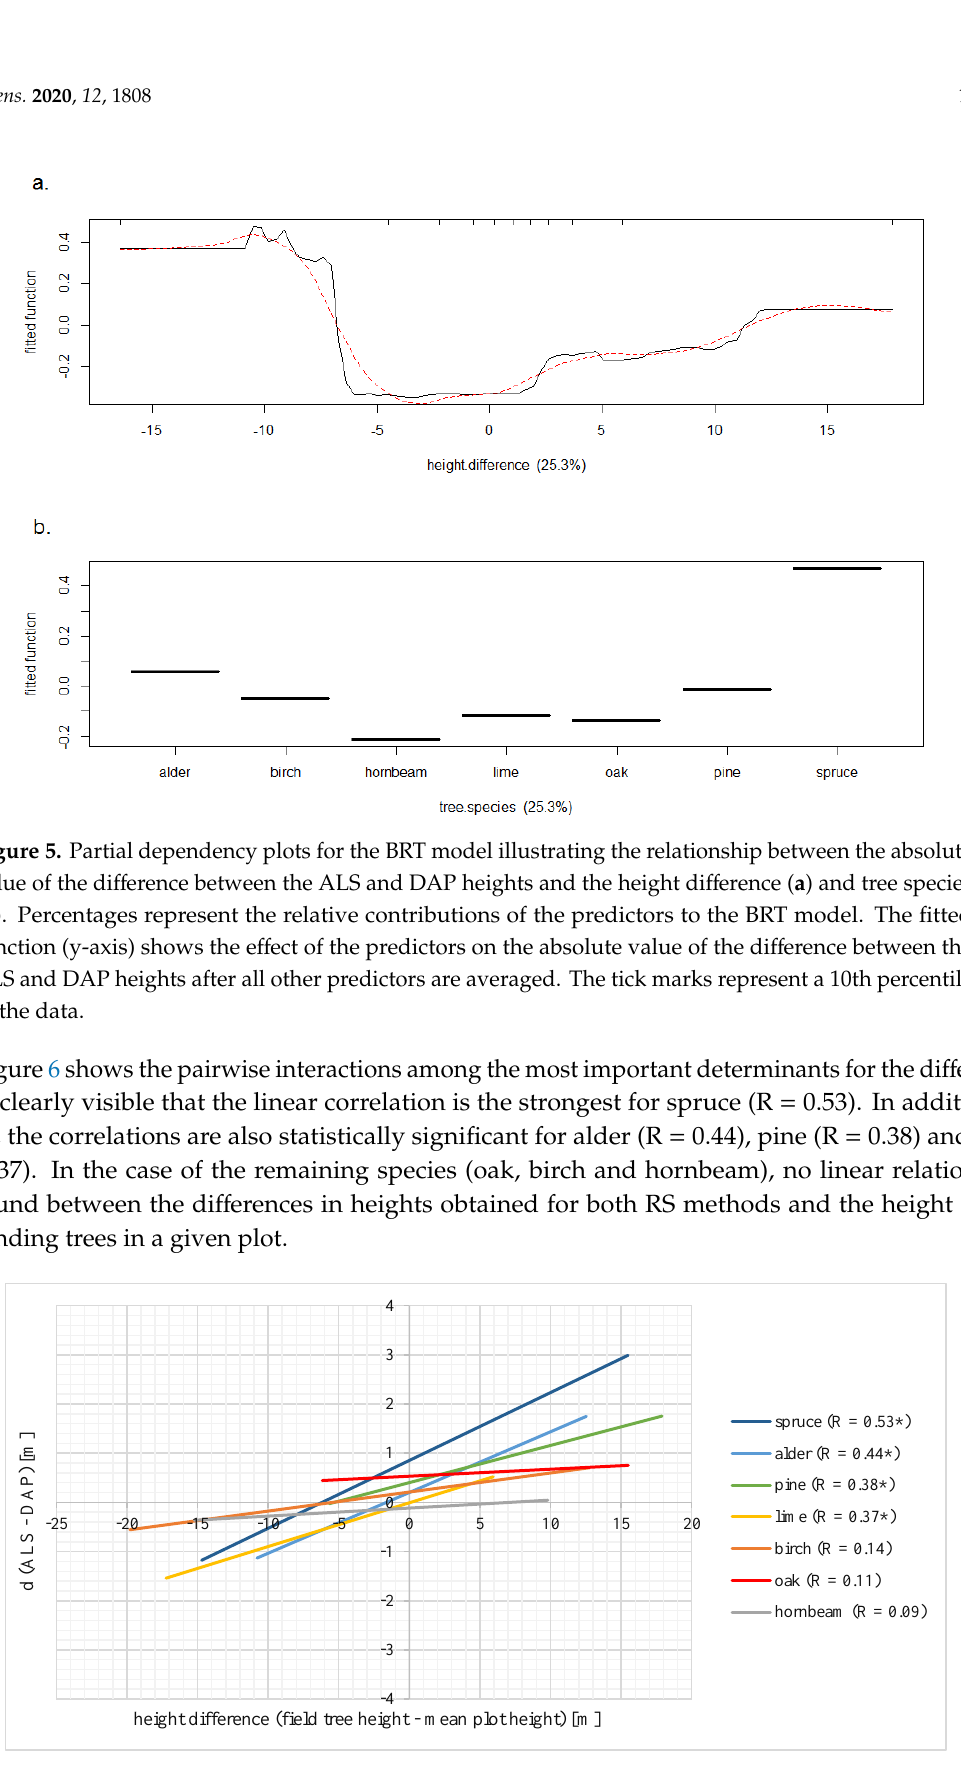
Figure 6. Interactive effect of the height difference (field tree height — mean plot tree height) and tree species based on a BRT analysis of the discrepancies between the ALS and DAP heights. Statistically significant correlations (p < 0.05) are marked with asterisks (*).